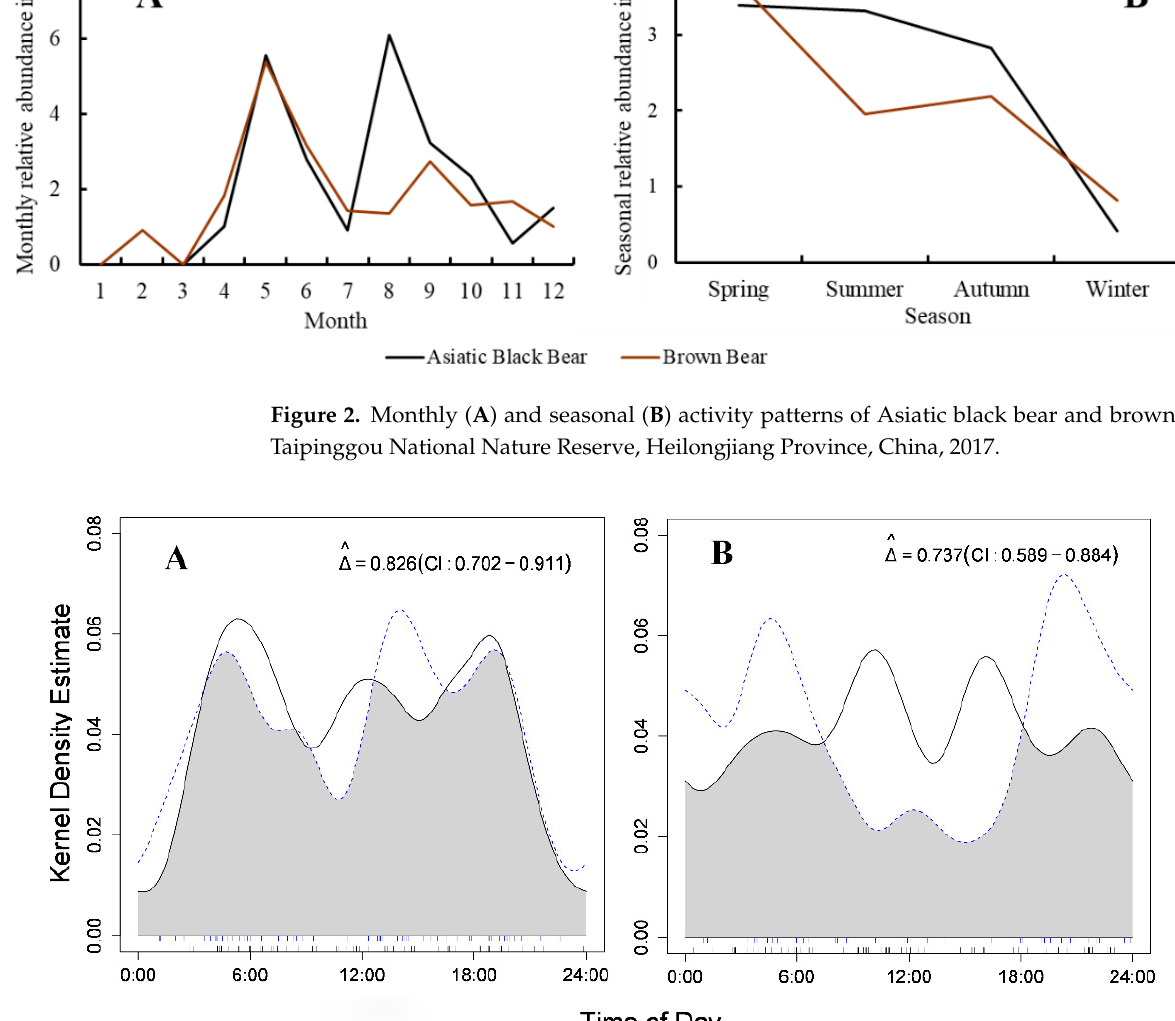
China, 2017. The mean value of the coefficient of overlap Δ(cid:3553) is represented by the light grey area the curves. Single–species detection was defined as independent detection of Asiatic black bear and